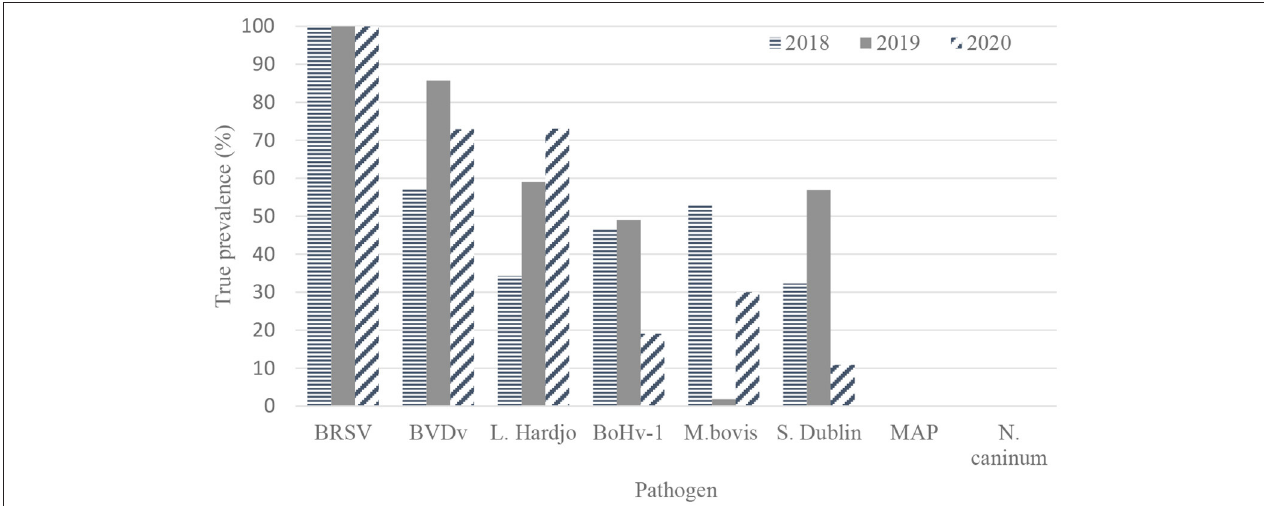
FIGURE 2 | True herd-level antibody prevalence estimates for BRSV (bovine respiratory syncytial virus) ( n = 120, 109, and 91 herds), BVDV (bovine viral diarrhea virus) ( n = 56, 56, and 48), L. Hardjo ( Leptospira Hardjo) ( n = 15, 21, and 10), BoHv-1 (bovine herpes virus-1, M. bovis ( Mycoplasma bovis ) ( n = 120, 109, and 91), S. Dublin ( Salmonella Dublin) ( n = 19, 22, and 13), MAP ( Mycobacterium avium subspecies paratuberculosis) ( n = 120, 109, and 91) and N. caninum ( Neospora caninum ) ( n = 120, 109, and 91) based on results from bulk tank milk sampling on 120, 109, and 91 unvaccinated dairy farms in 2018, 2019, and 2020,